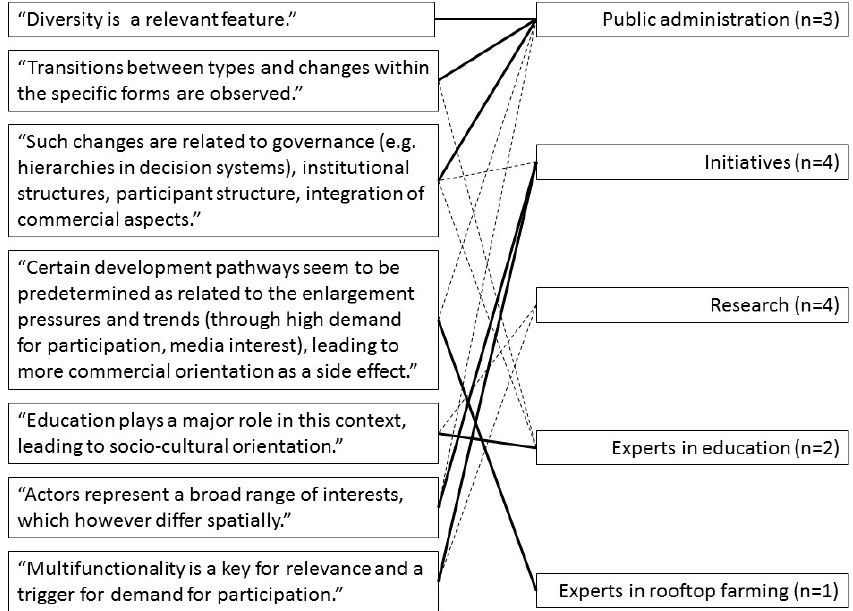
Figure 3. Statements from the stakeholder workshop. Solid lines connect the statements to the original contributor of that statement, dotted lines represent groups who confirmed and expanded on the statement.